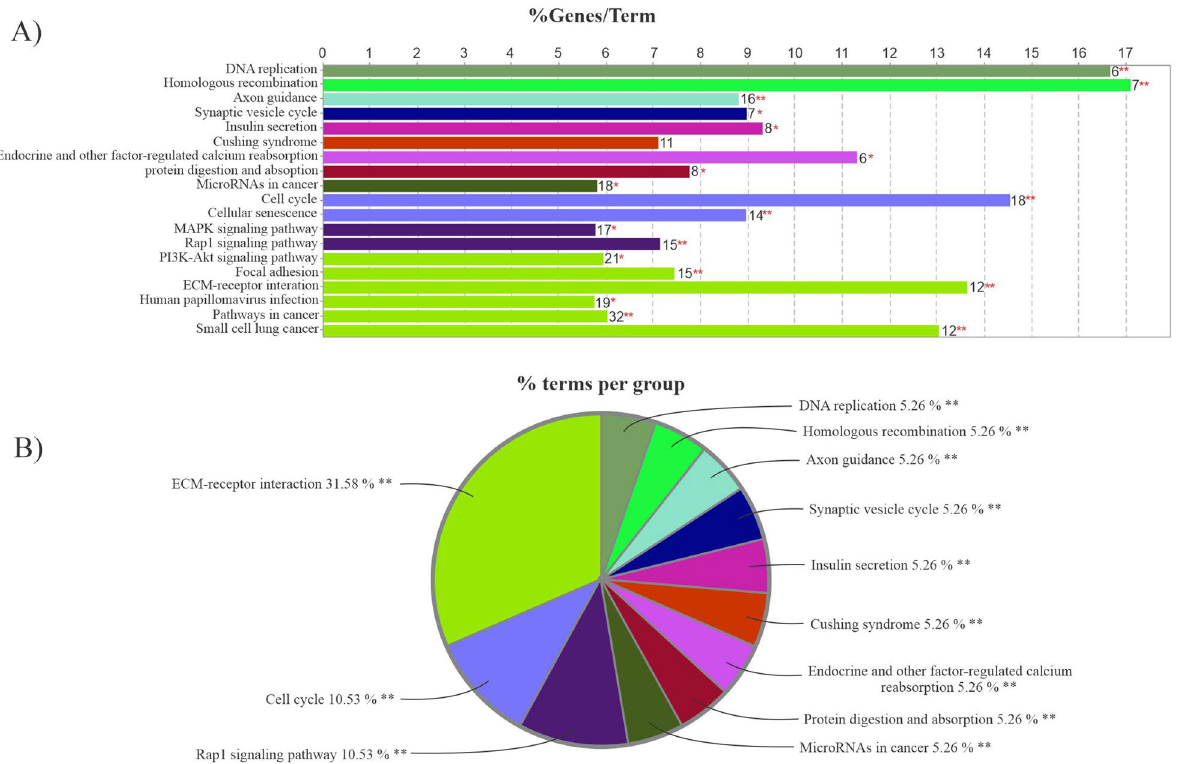
Figure 8. KEGG pathway analysis. ( A) The bars in the chart represent the number of analyzed genes associated with each term. The numbers at the top of the bars indicate the percentage of detected genes relative to all of the genes related to the term. ( B) The pie chart depicts an overview of the functional groups for FImRNAs. Groups are named based on the most significant term in each group. The bar plot and pie chart were visualized using clueGO (Cytoscape